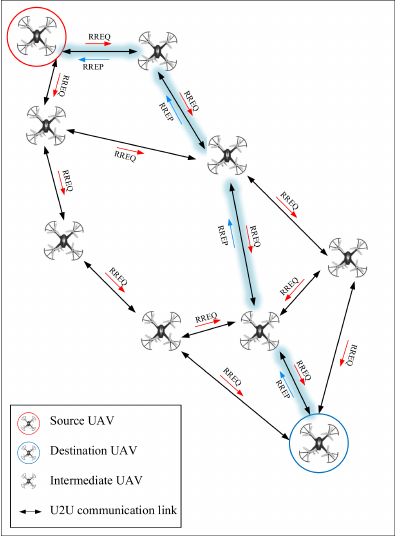
Figure 19. Route discovery